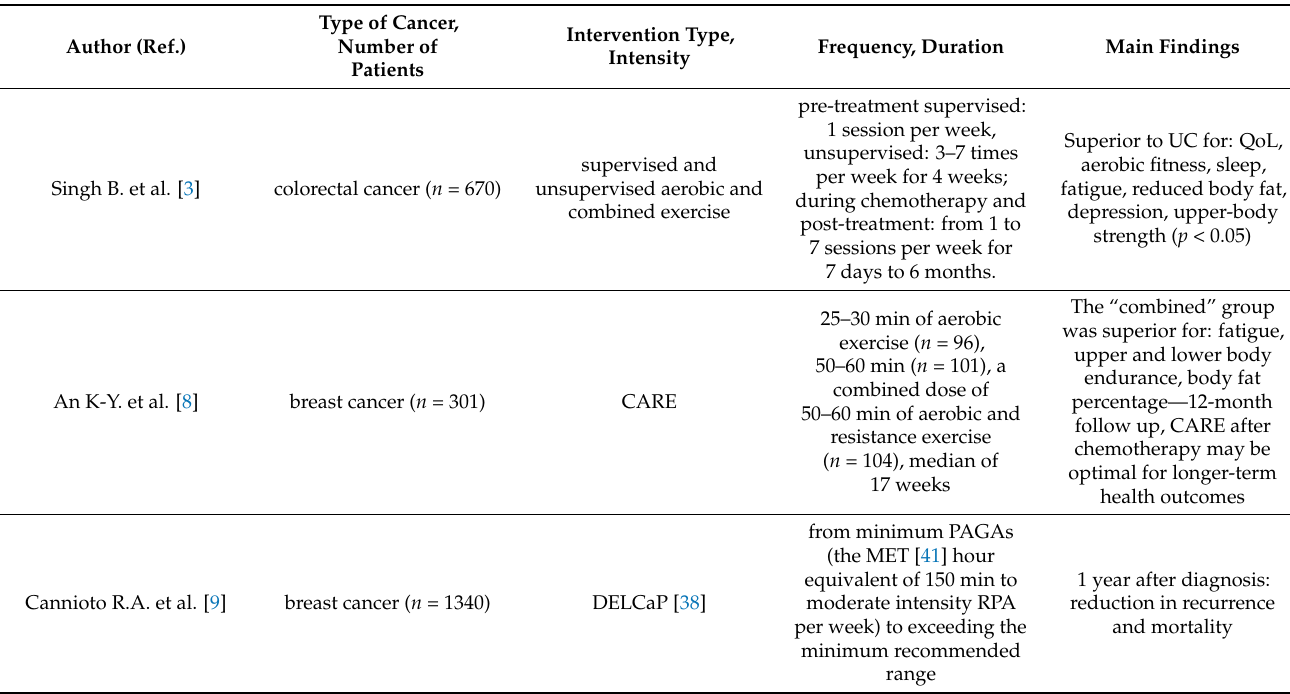
Table 1. Comparison of the influence of physical activity on cancer